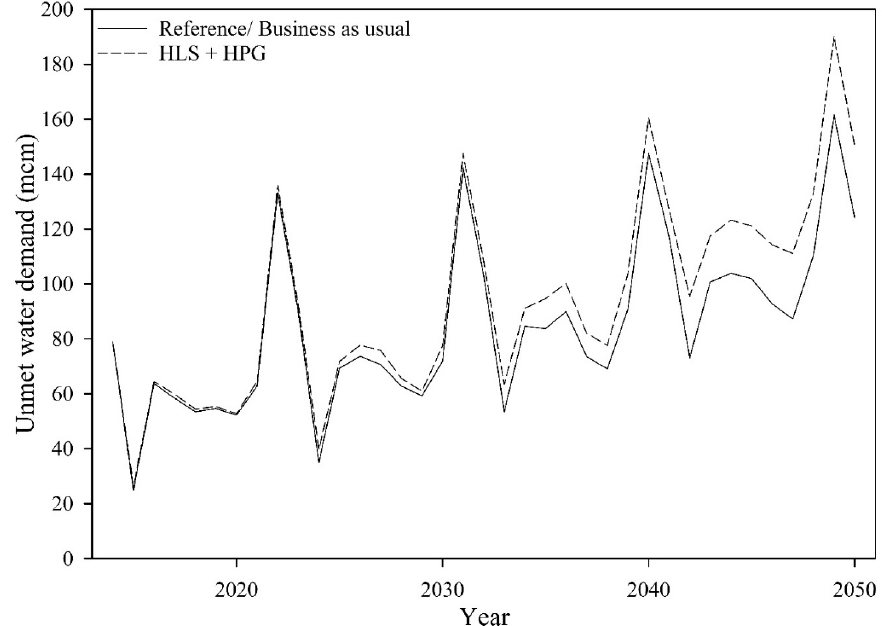
Figure 13. The future projections of the unmet water demands in the Upper Indus Basin (UIB) under the reference and high population growth + high living standards scenarios for the period